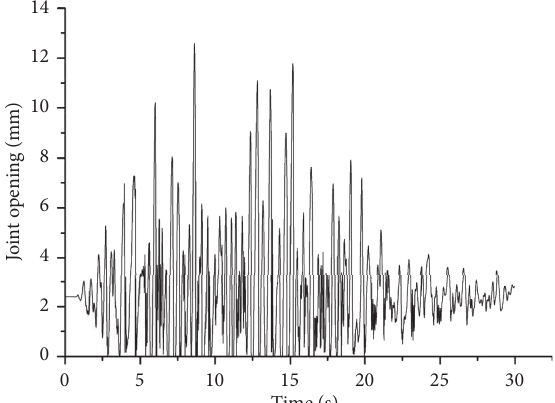
Figure 16: Time history of joint opening at the downstream side of the dam crest for #16 joint.